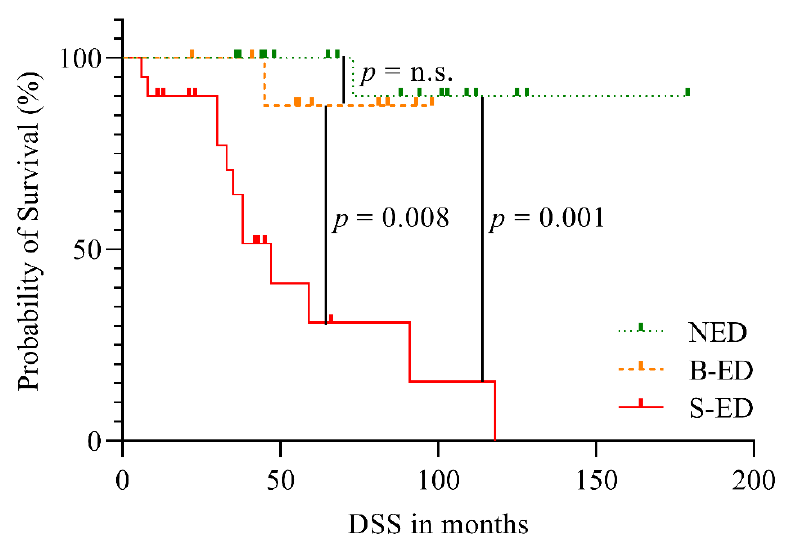
Figure 2. Kaplan – Meier estimate of DSS in the NED, B-ED and S-ED groups; DSS, disease-specific survival; ED, evidence of disease; N, no; B, biochemical; S, structural, n.s., not significant